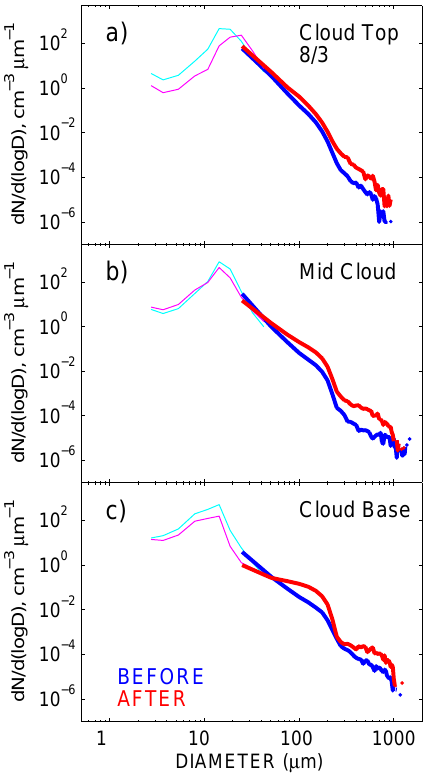
Figure 7. Drop size distributions (DSDs) obtained from level legs at (a) cloud top, (b) mid-cloud, and (c) cloud base before (blue) and after (red) seeding on 3 August 2011. DSDs are calculated from CAS (thin) and CIP (thick) probes for the pre- and post-seeding legs. “BEFORE” and “AFTER” indicate pre- and post-seeding legs, respectively. The values are based on the averages for each level leg, shown in Fig. 4 and Table